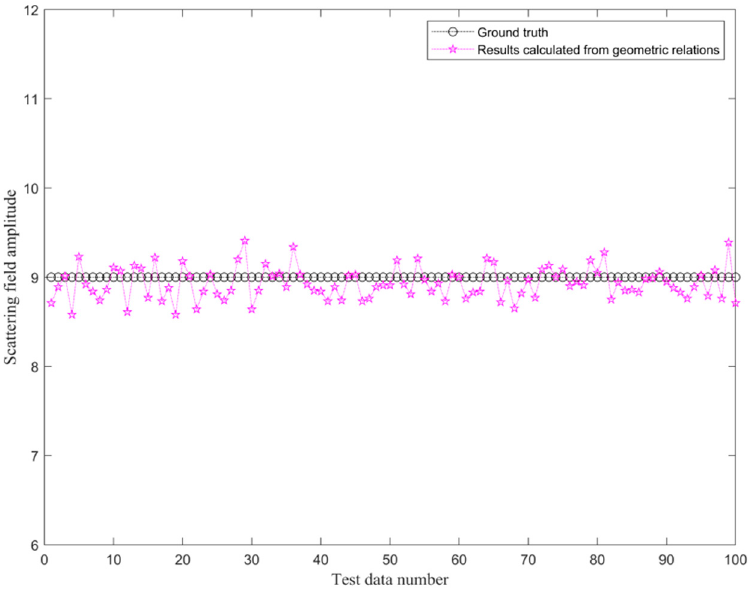
Figure 8. Calculation results of ε r